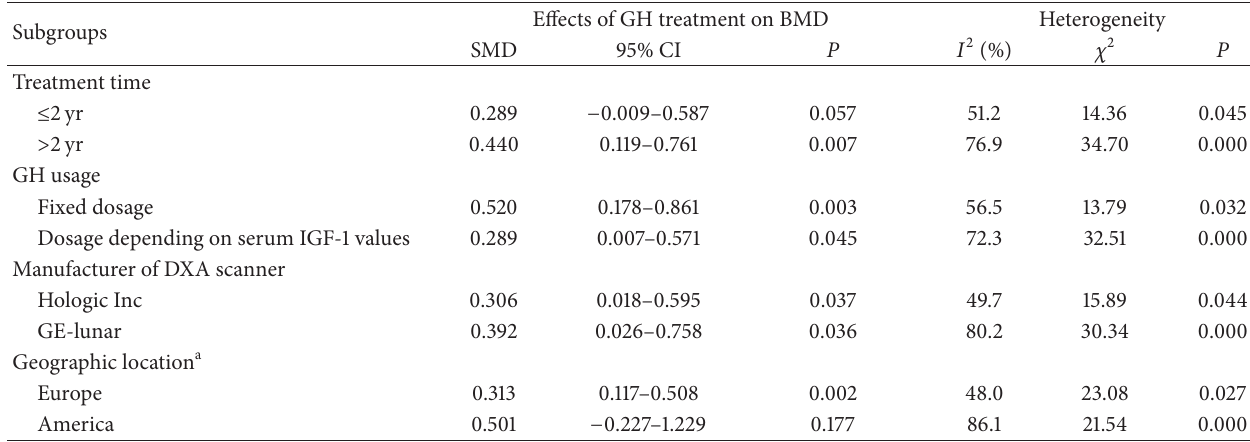
Table 4: Subgroup analyses results of the association between GH treatment and BMD of FN.